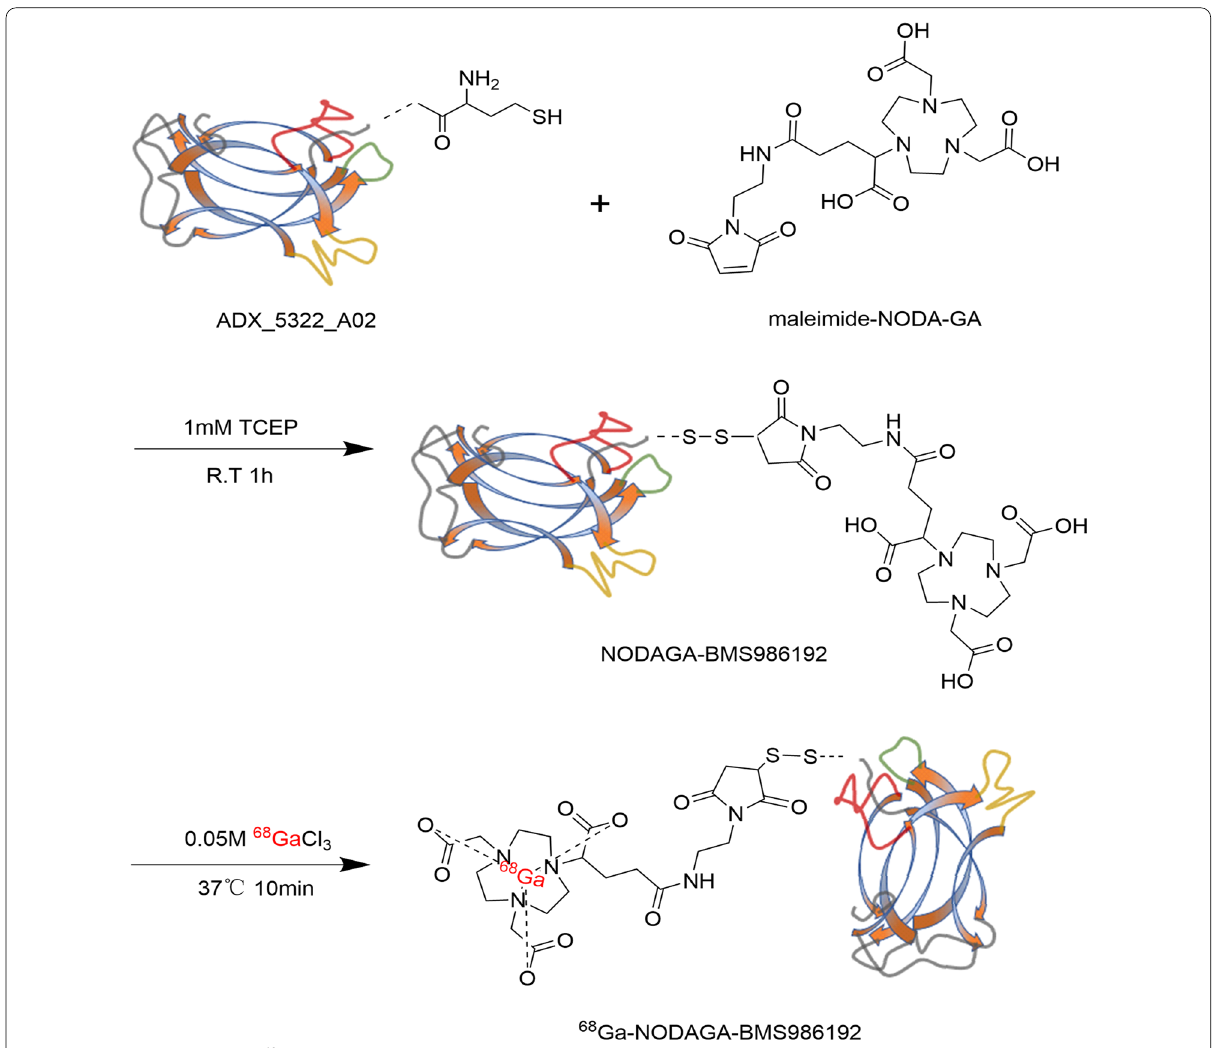
Fig. 1 Synthesis schematic of 68